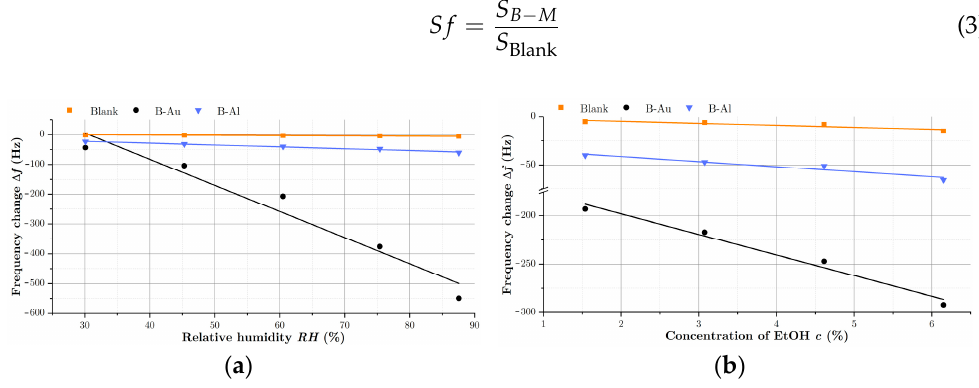
Figure 7. Calibration curves and sensor sensitivity factors from sensor responses to H 2 O in ( a ) and towards vapors of EtOH in ( b ). Table 4. Sensitivity of prepared QCMs with black metal coatings.